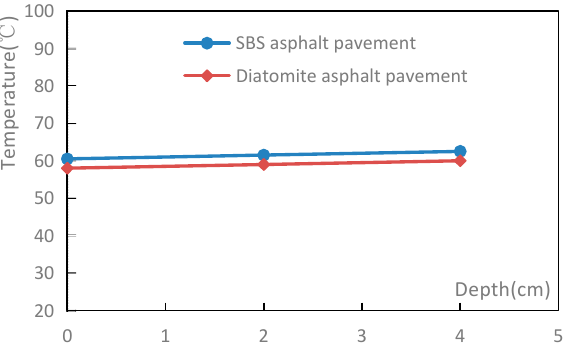
Figure 5. Temperature variation law of different asphalt mixtures during heating.